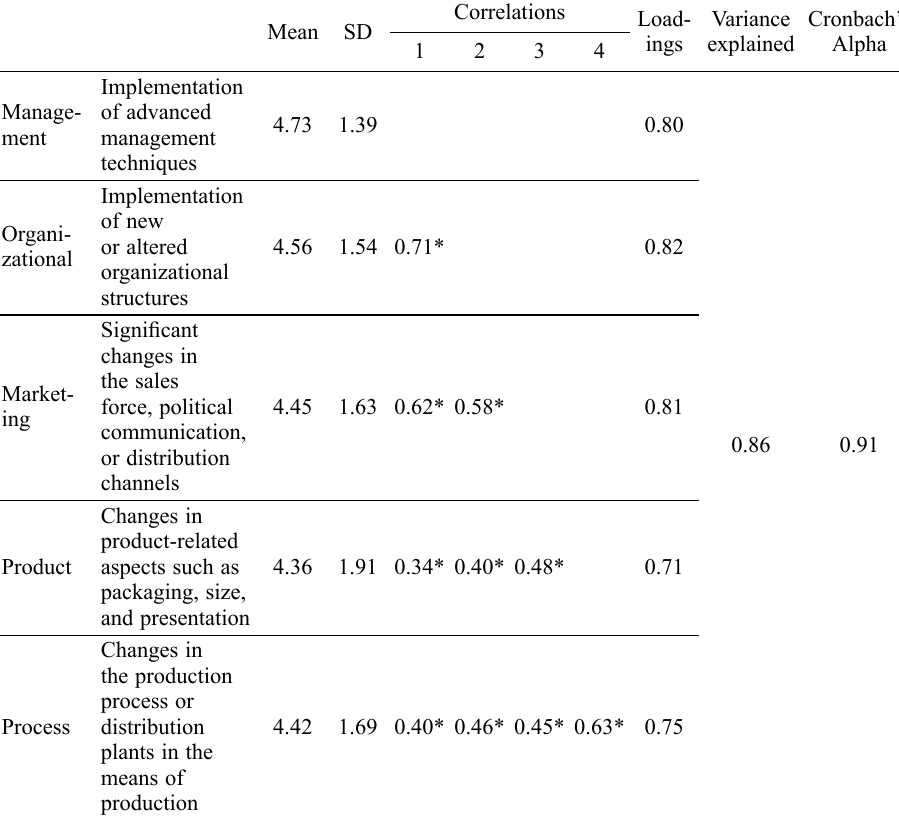
Table 3. Measurement of incremental